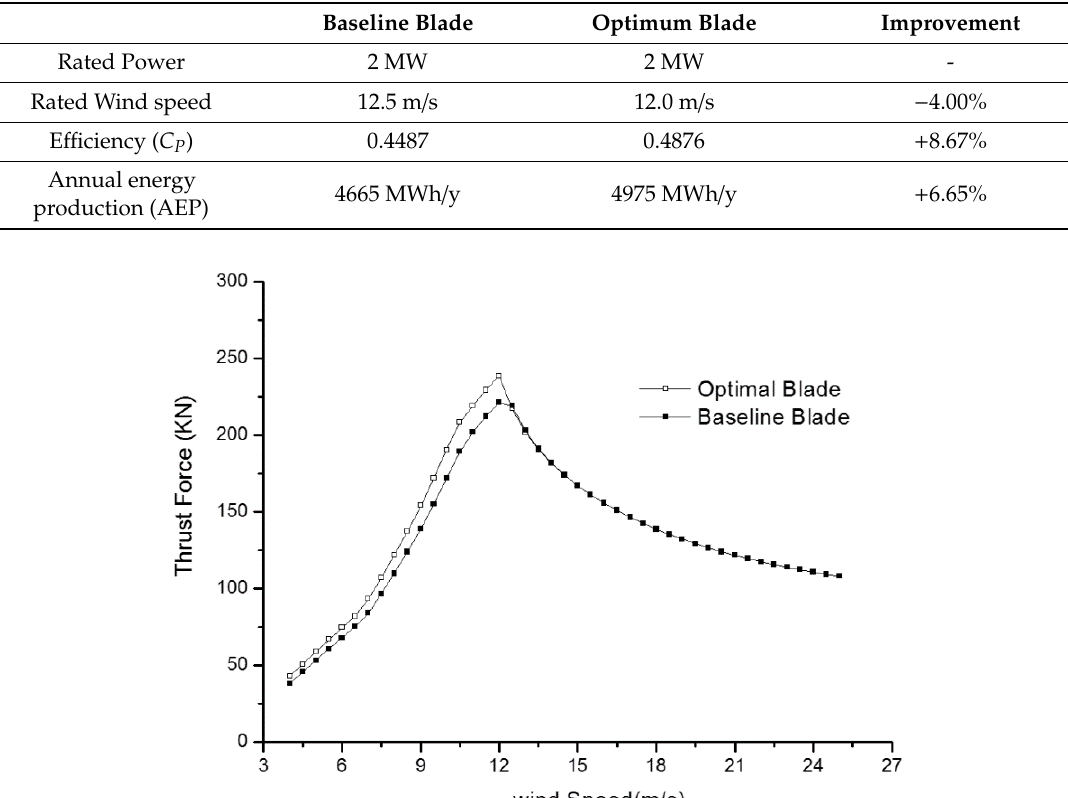
Figure 11. Thrust force comparison between the optimal and baseline blades.